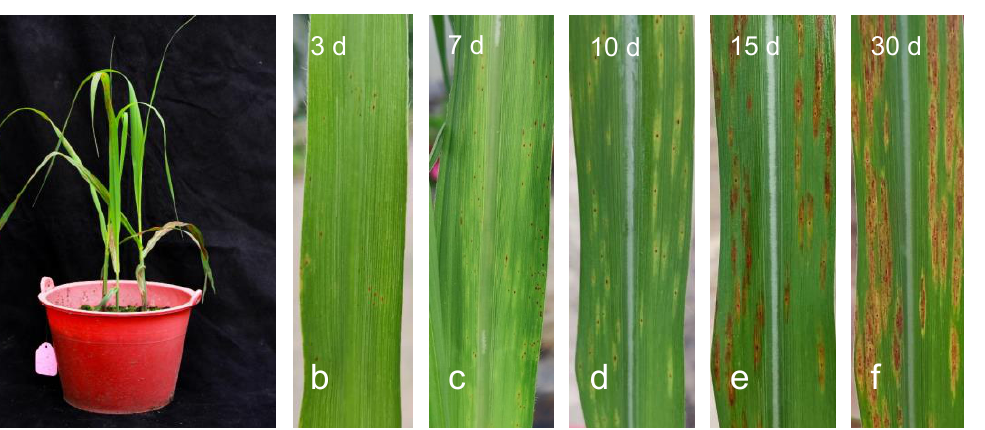
Figure 2. Symptoms of sugarcane leaf blight caused by isolate SF007. ( a ). Sugarcane plants infected for 15 days; ( b ). leaf infected for 3 days; ( c ). for 7 days; ( d ). for 10 days; ( e ). for 15 days; ( f ). for 30 days. Plants were kept in a glasshouse at 25 – 28 °C.